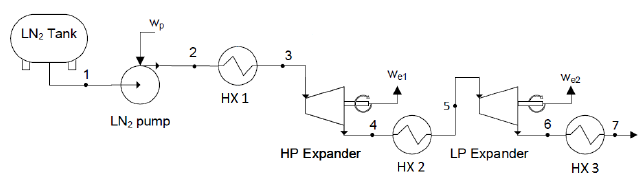
Figure 2. Scheme of 2-stage direct expansion LN 2 exergy recovery